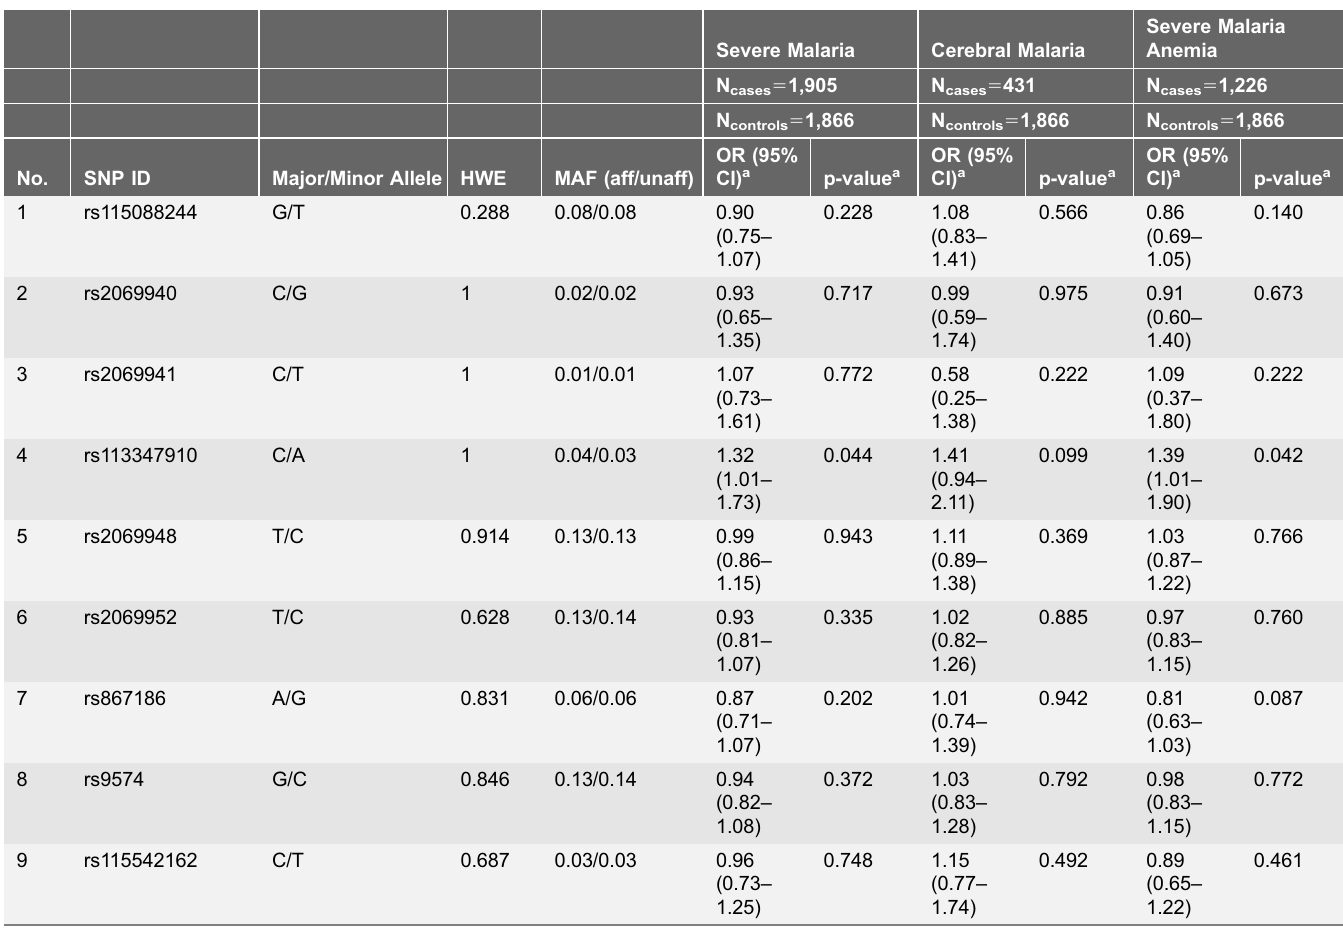
Table 2. Association tests of PROCR SNPs (MAF $ 1%) with severe malaria, cerebral malaria, and severe malaria